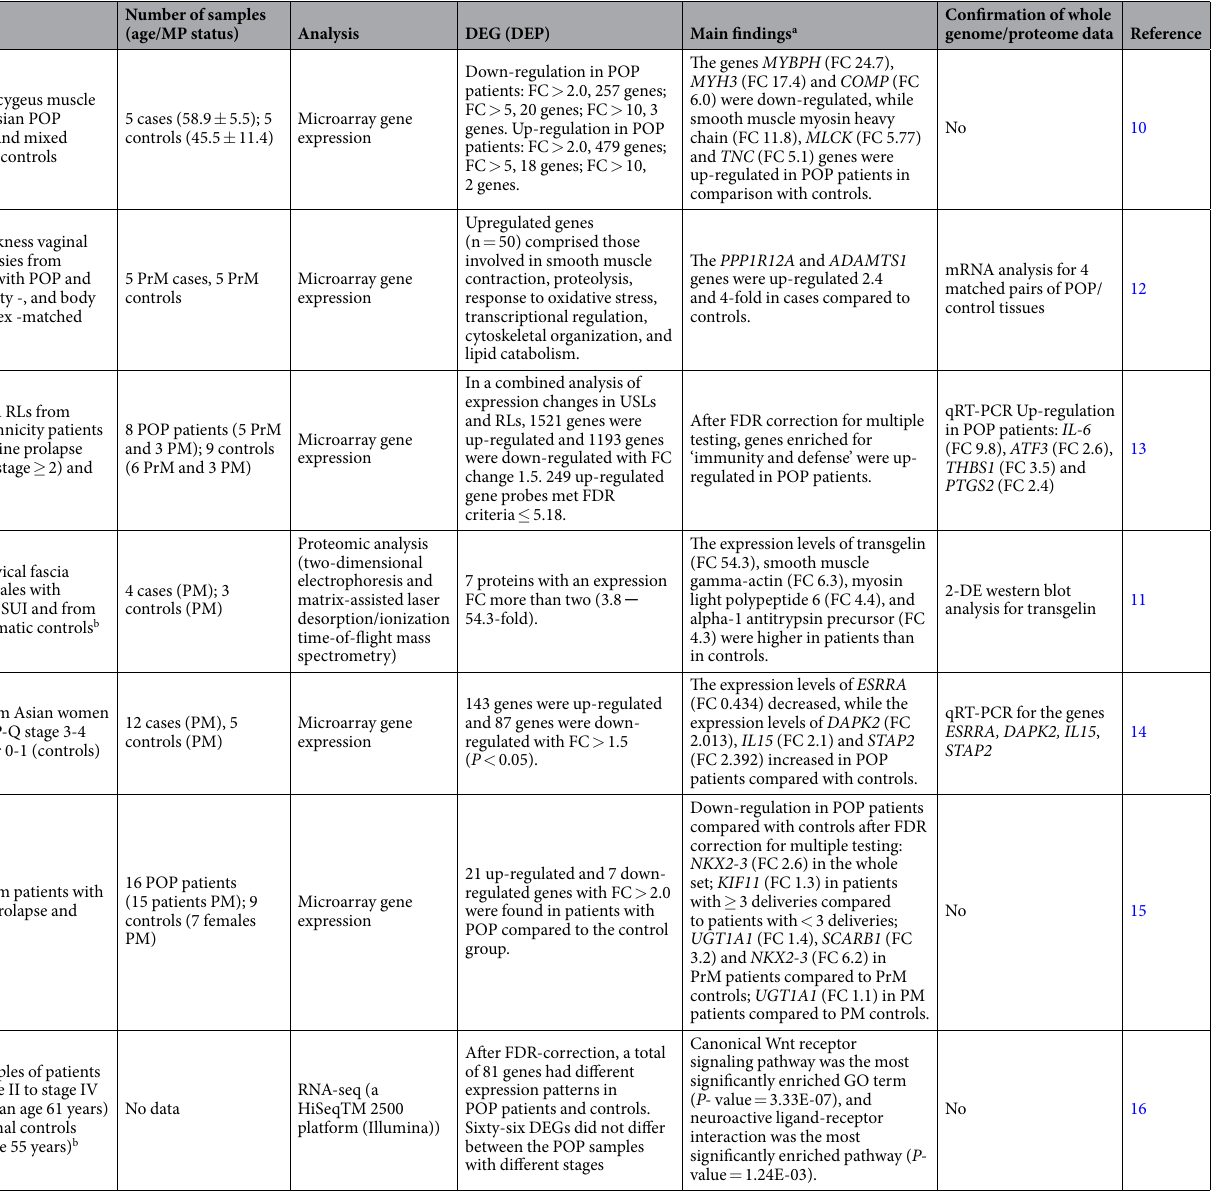
Table 1. Characteristics of the whole genome/proteome studies of POP. a Data are uncorrected for multiplicity, otherwise specified. b Ethnicity is not specified. Abbreviations: DEG, differently expressed genes; DEP, differently expressed proteins; FC, fold change; FDR, false discovery rate; PM, postmenopausal; PrM, premenopausal; RLs, round ligaments; SUI, stress urinary incontinence; USLs, uterosacral